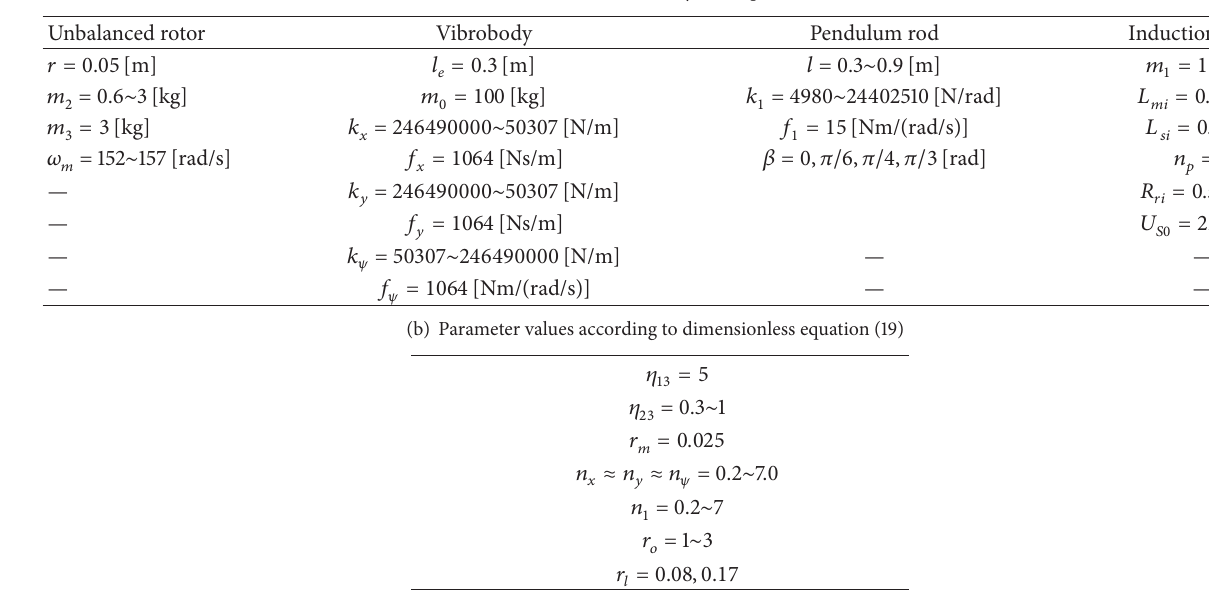
Table 1: Parameter values. (a) Parameter values for system equation